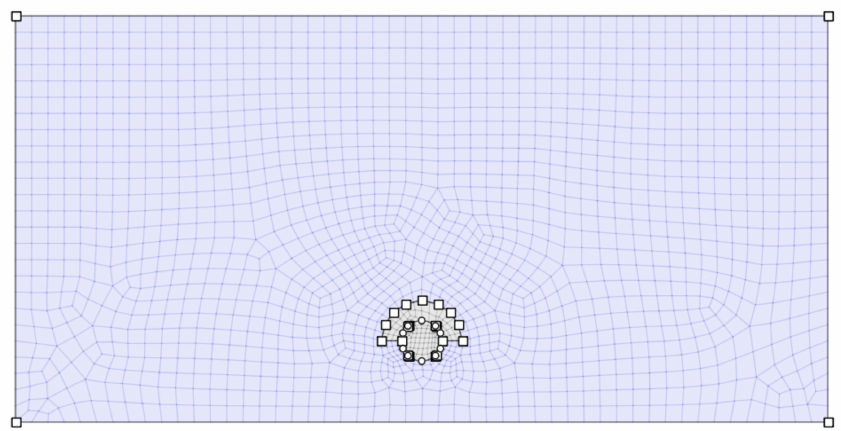
Figure 2. Setting of mesh for numerical